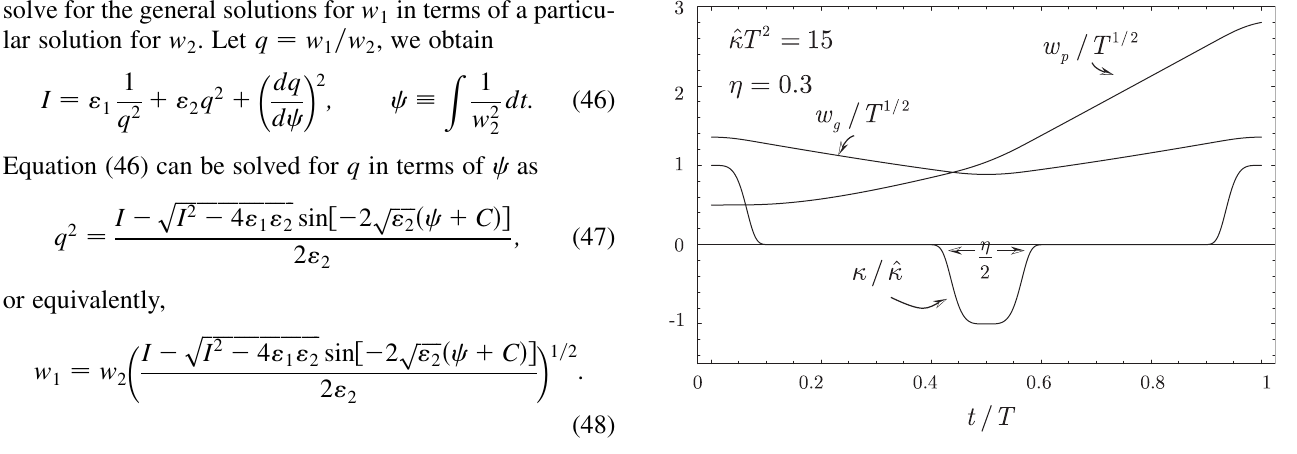
is constructed from an arbi- g for a FODO focusing s